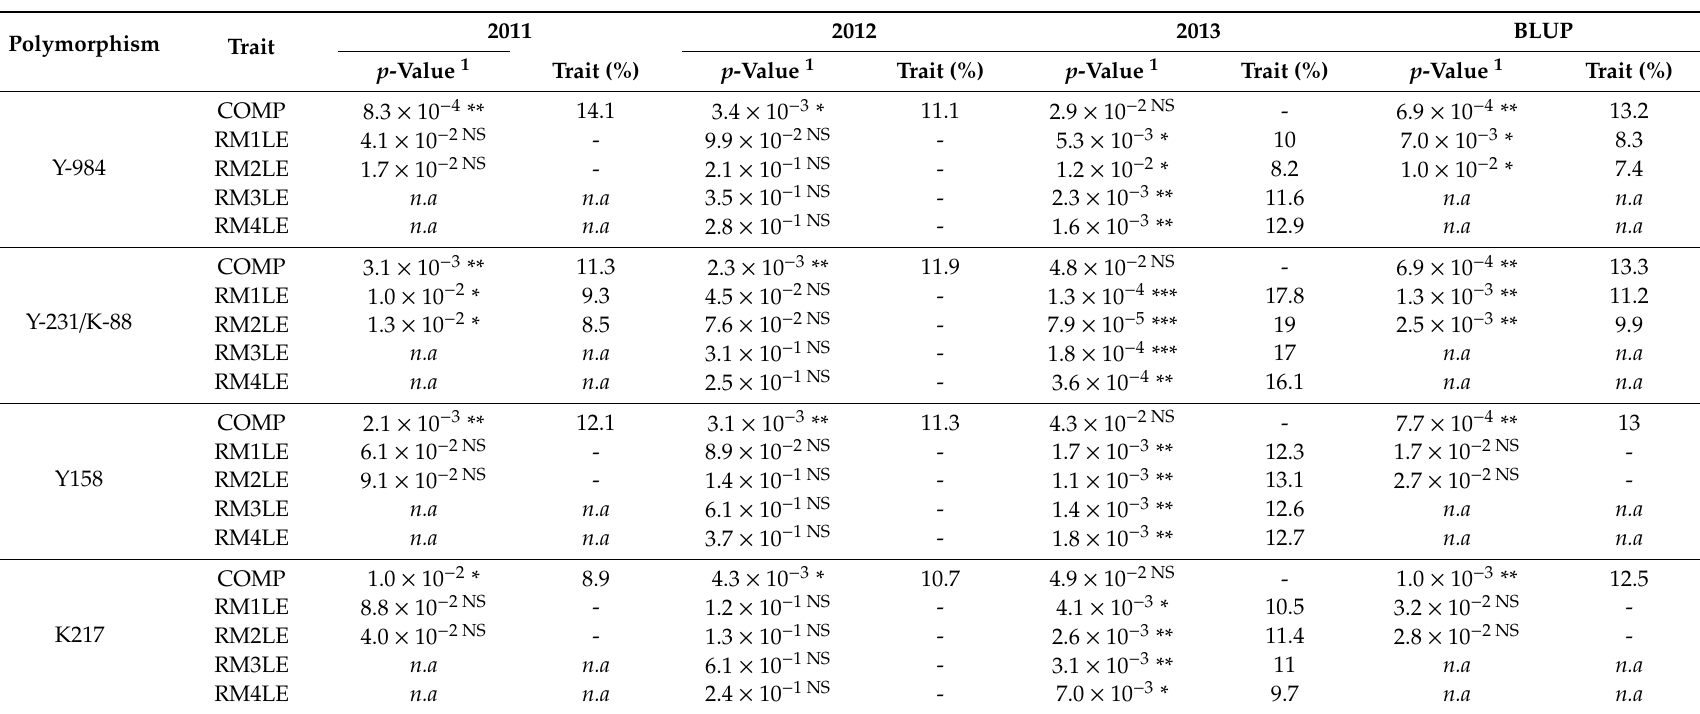
Table 4. Association results obtained between VviUCC1 polymorphisms and cluster compactness and five rachis architecture traits (seasonal data and BLUP values).